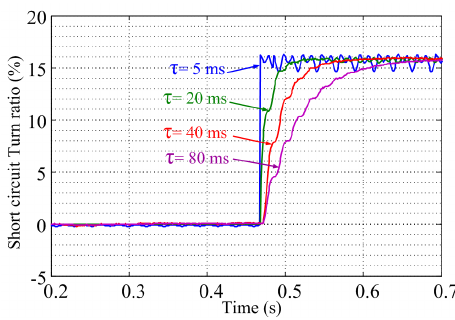
Figure 31. Estimation response with different τ at a constant frequency of 30 Hz.